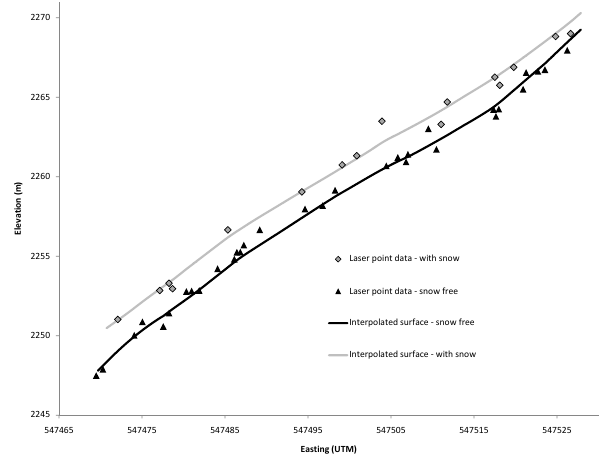
Fig. 2. Measured laser point data and local polynomial interpola-